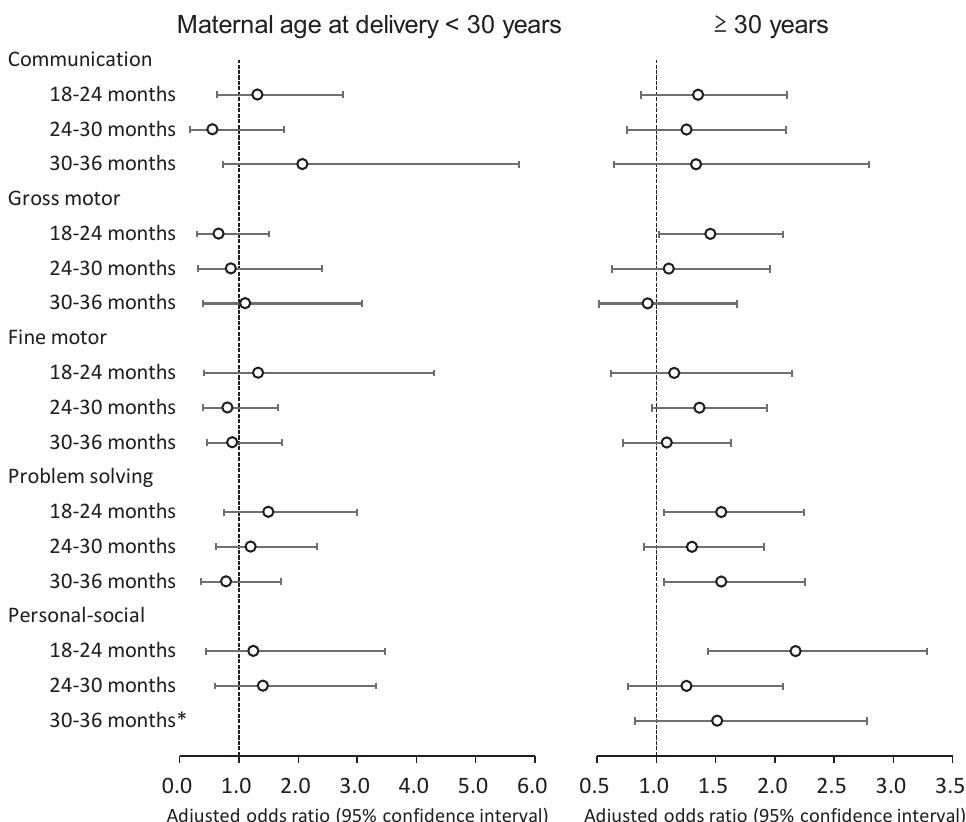
Fig. 5 Association of epidural analgesia with the incidence of neurodevelopmental delay among children, by maternal age Adjusted odds ratios (95% con fi dence intervals) for the incidence of neurodevelopmental delay in each domain of the J-ASQ-3 among children born to mothers who received epidural analgesia during labor are shown, every 6 months after 18 months, strati fi ed by maternal age at delivery ( < 30 years / ; 30 years). Adjusted for parity, delivery mode, duration of labor, comorbidity (diabetes and hypertension), body mass index before pregnancy, occu- pation in the fi rst trimester, smoking status, alcohol consumption, educational level, annual household income, marital status at 6 months after childbirth, child ’ s sex, birth weight, Apgar score at 5min after birth, feeding methods in infancy, nursery attendance, screen time at 12 months old, siblings cohabiting with the child, and study area. A multiple imputation method was used to reduce potential selection bias from missing variables. For personal-social delay during 30 – 36 months in < 30 years, adjusted odds ratio could not be calculated due to the small number of the subjects. Abbreviations: J-ASQ-3, the Japanese translation of the Ages and Stages Questionnaires, Third